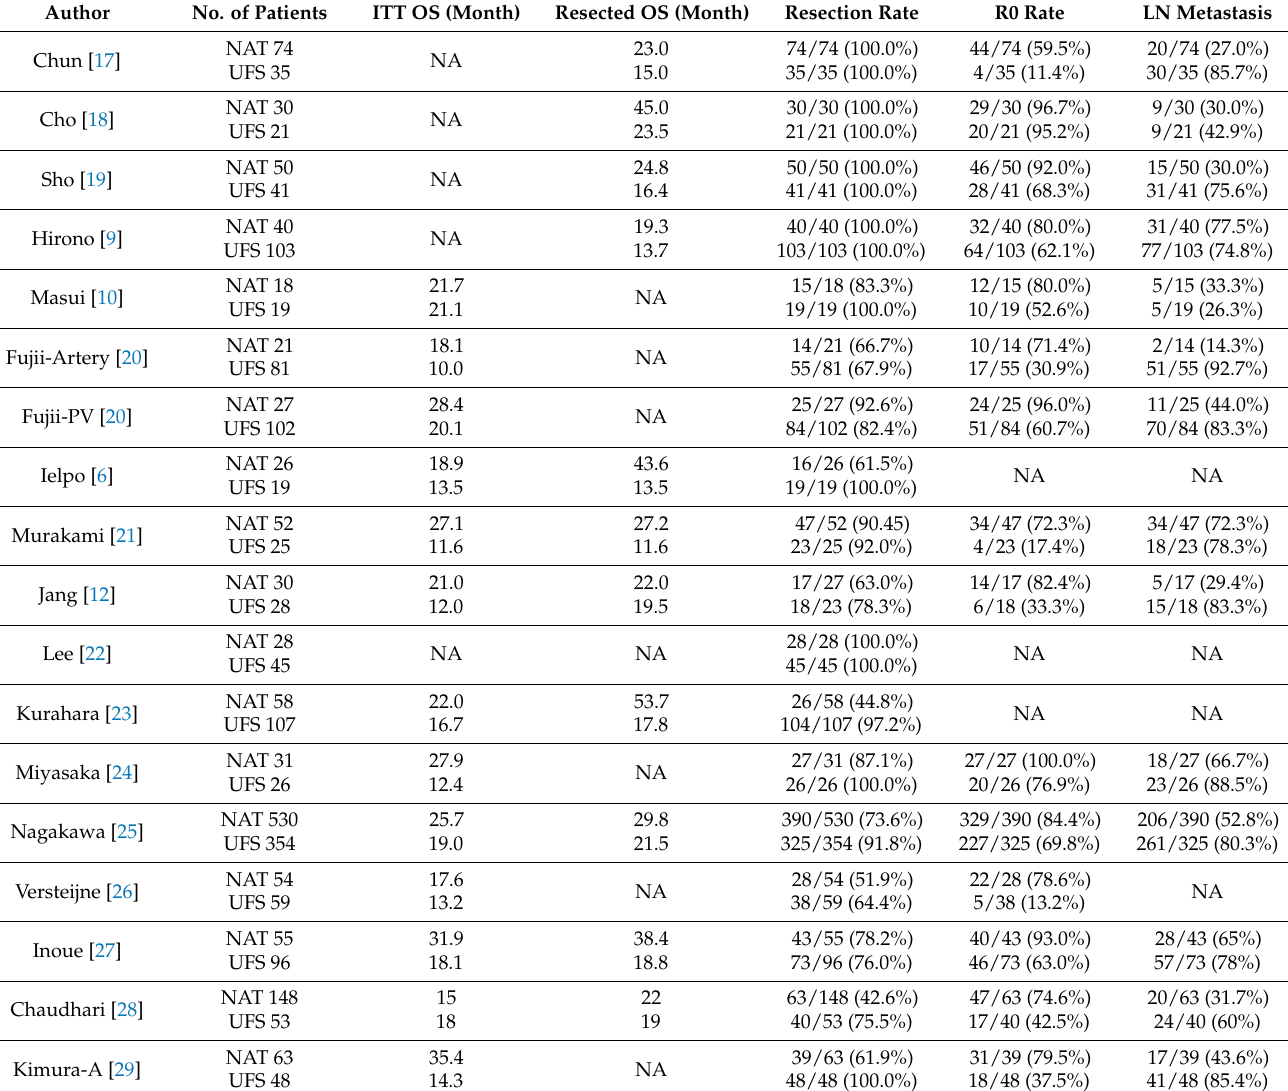
Table 2. Clinical outcomes of included